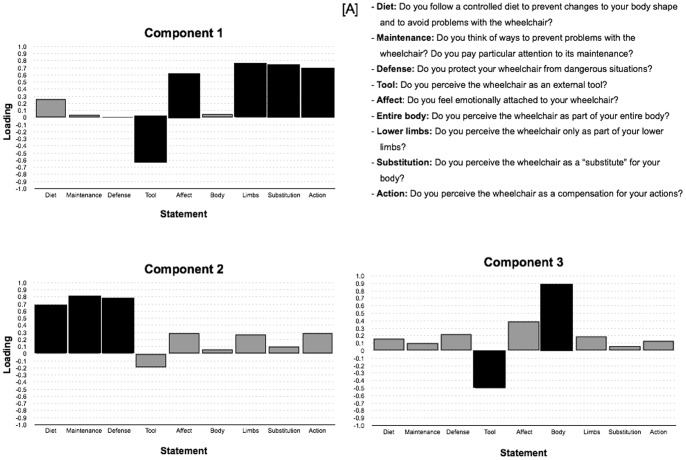
Loadings of the statements on the three principal components extracted.The labels on the x-axis refer to the statements shown in panel A. Black bars indicate the statements with the highest loadings (≥0.5) for each component. A. Statements used to assess wheelchair embodiment.